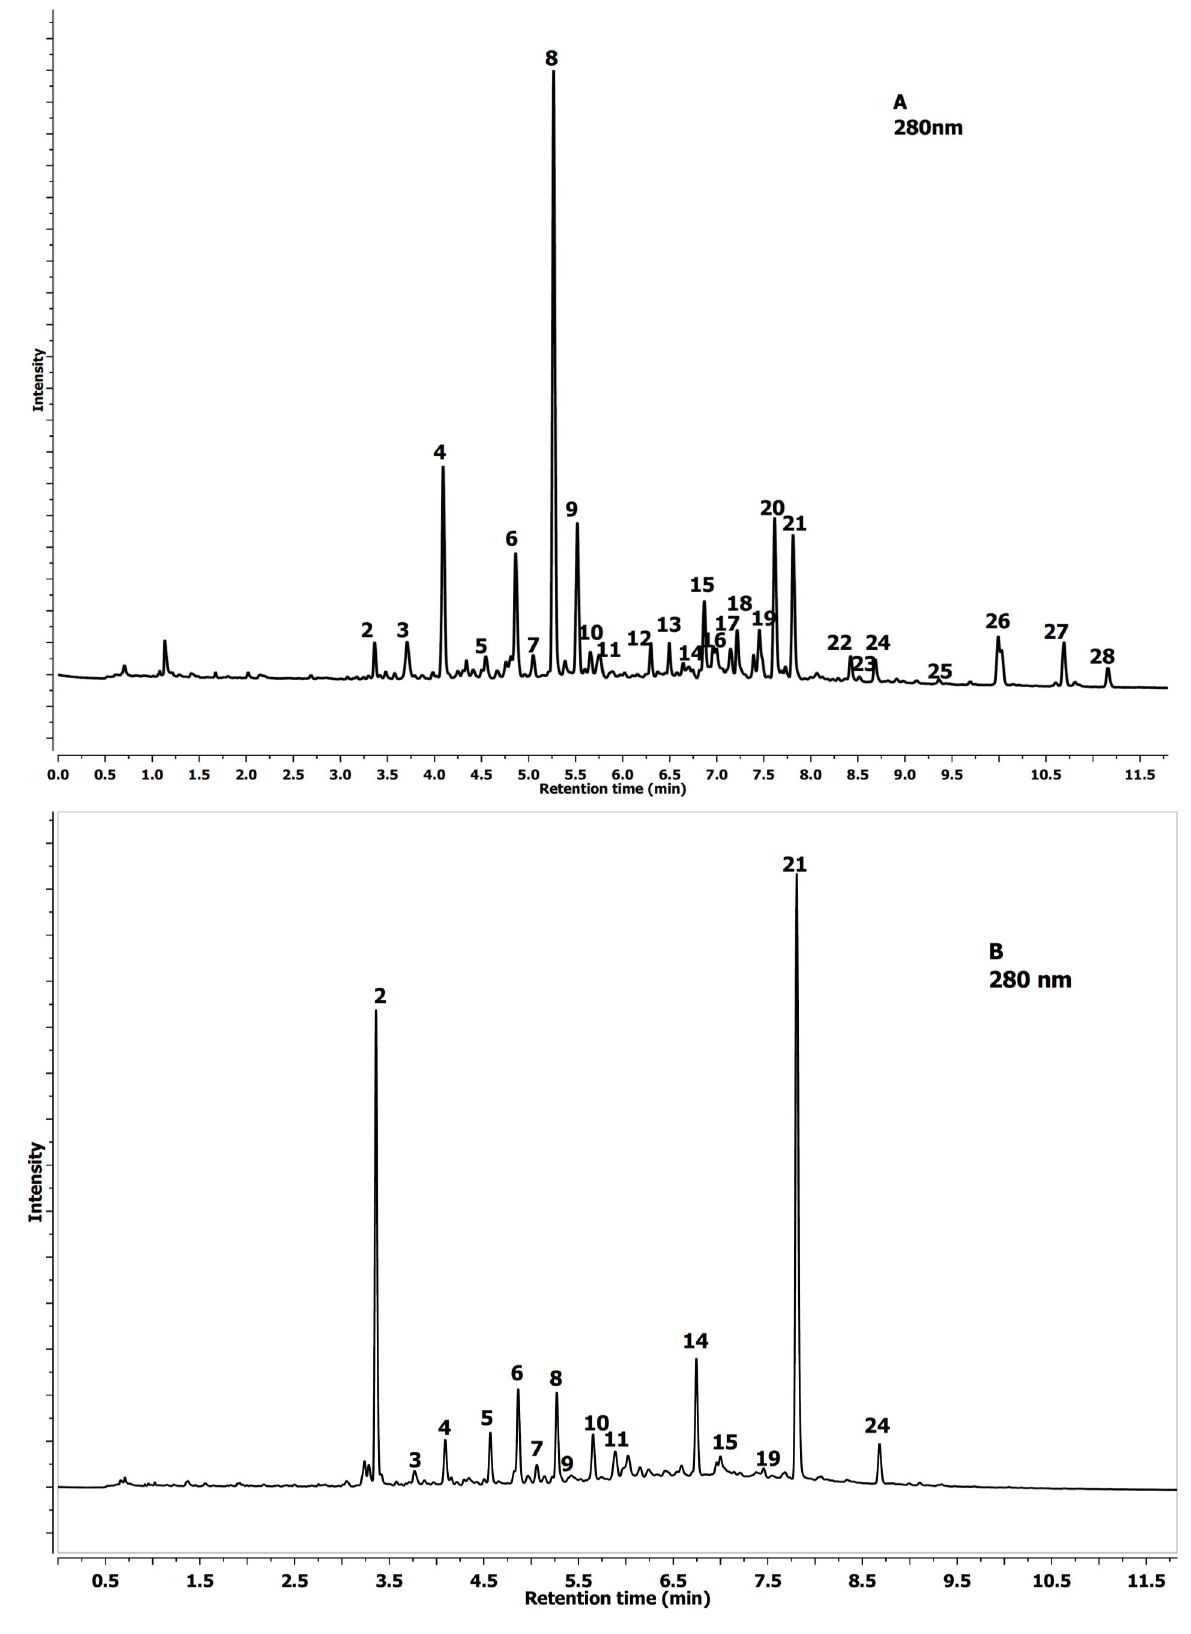
Figure 2. UPLC chromatogram profile Aesculus glabra ( A ); and Aesculus parviflora Walt.; ( B ) leaf extracts at 280 nm